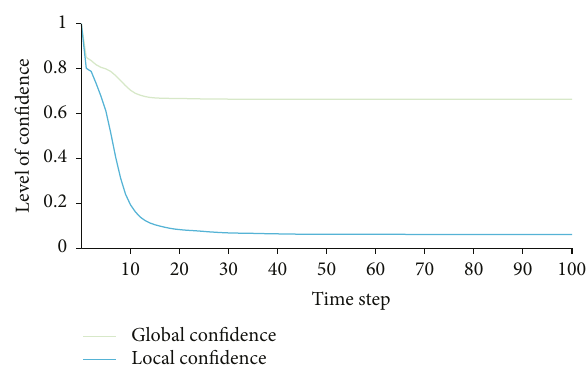
Figure 13: Time course of global and local con fi dence. Global con fi dence is calculated in a standard way as in the complete information (CI) scenario. Local con fi dence is an average of individual con fi dences of all banks in the local information (LI) LI1 scenario. CI is a scenario in which a bank has access to information from all other banks in the network. LI1 is a scenario in which a bank has access only to information from banks at distance 1.